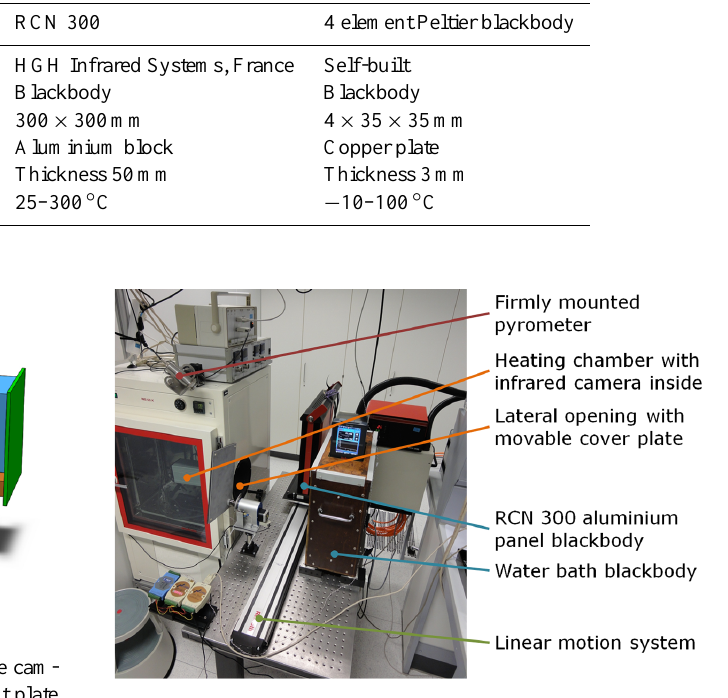
Figure 5. Photograph of the calibration